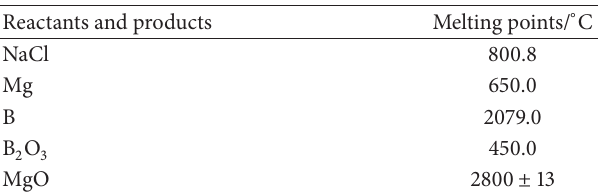
Table 1: Melting points of reactants and products. Reactants and